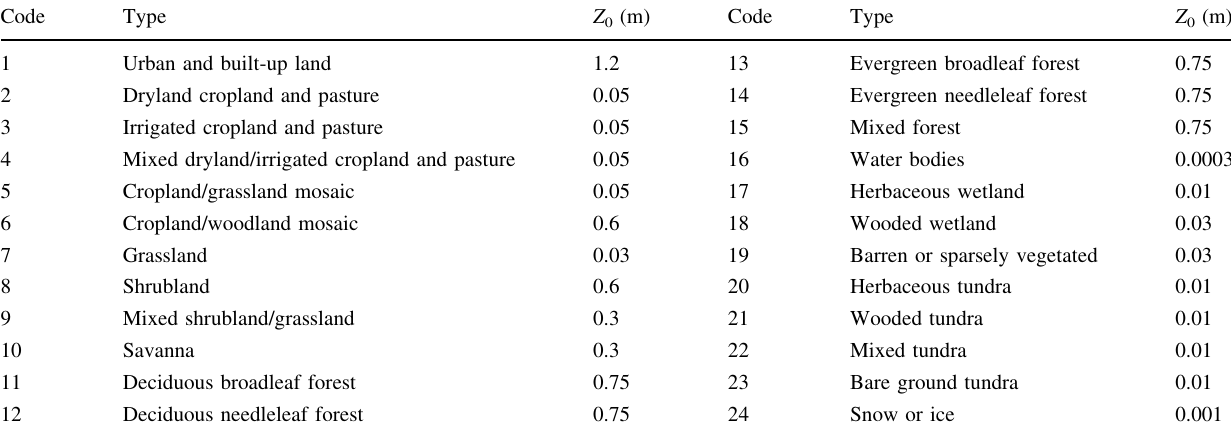
Table 2 Look-up table for the surface roughness length and the USGS Land Use / Land Cover System Code